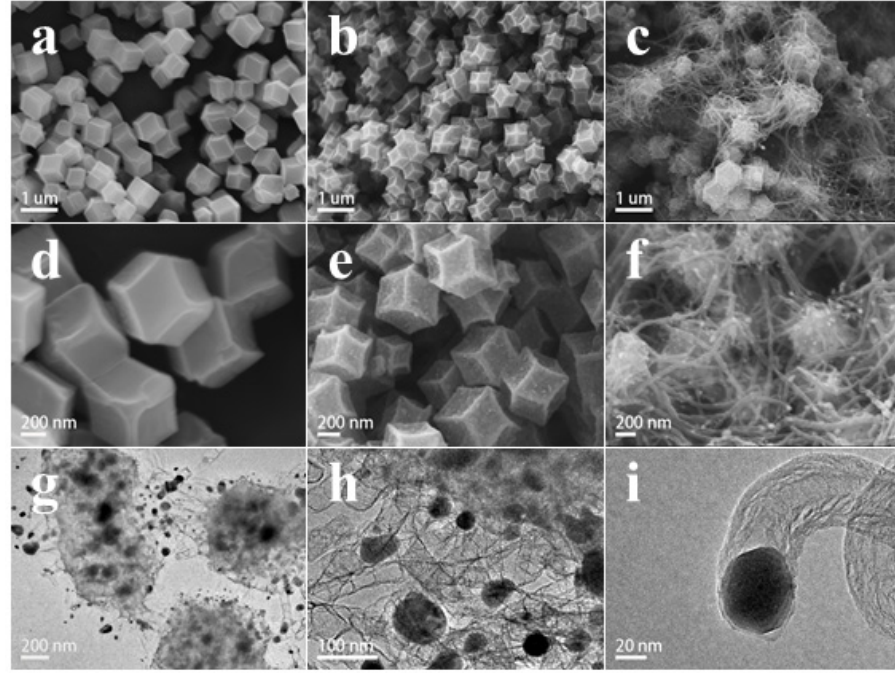
Figure 2. SEM images of ZIF-67 ( a ), Co/NC ( b ) and Co/Mel ( c ); FESEM images of ZIF-67 ( d ), Co/NC ( e ) and Co/Mel ( f ); HRTEM images of Co/Mel ( g – i ).